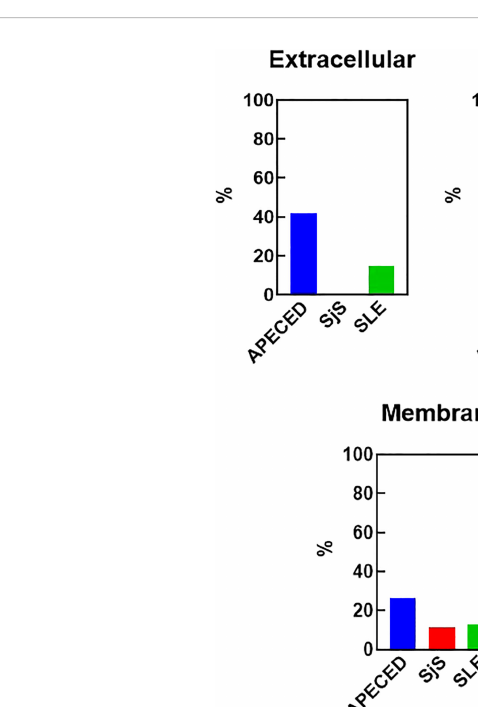
(CDR) 3 length, and VH mutation rate were investigated. Figure 8A